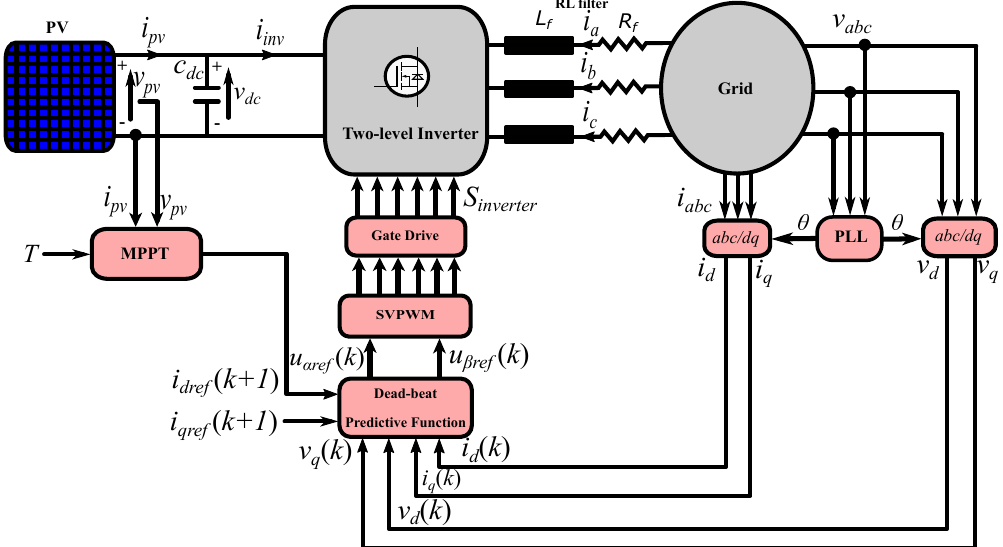
Figure 12. The proposed control strategy for grid-connected PV